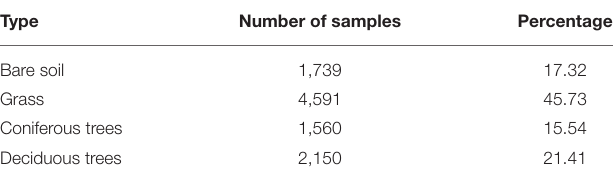
TABLE 2 | The training data